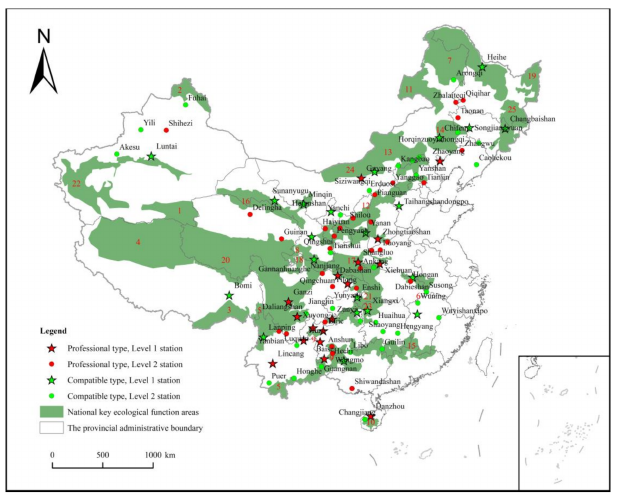
Figure 7. Layout of monitoring stations in national key ecological function areas (Notes: 1: Altun grassland desertification control ecological function area; 2: Altai mountain forest and grassland ecological function zone; 3: Forest ecological function area of plateau margin in southeast Tibet; 4: Desert ecological function area of Qiangtang Plateau in northwest Tibet; 5: Sichuan–Yunnan forest and biodiversity conservation ecological function zone; 6: Dabie Mountain soil and water